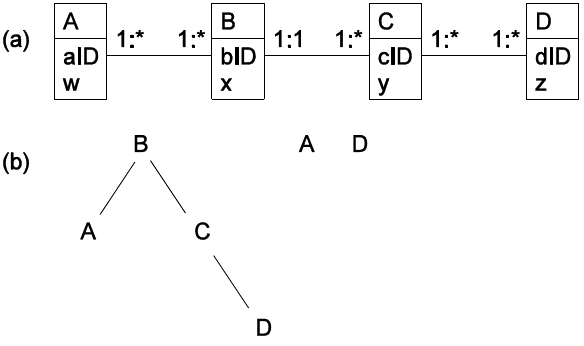
Figure 8. A sample class diagram and some sample JSON scheme trees